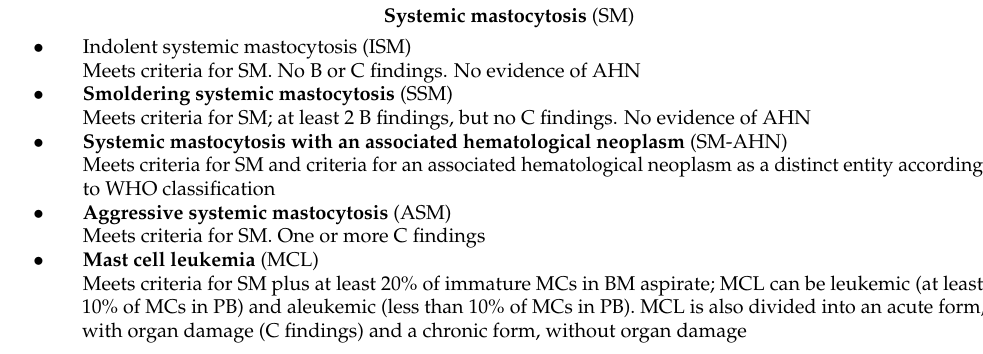
Systemic mastocytosis (SM)